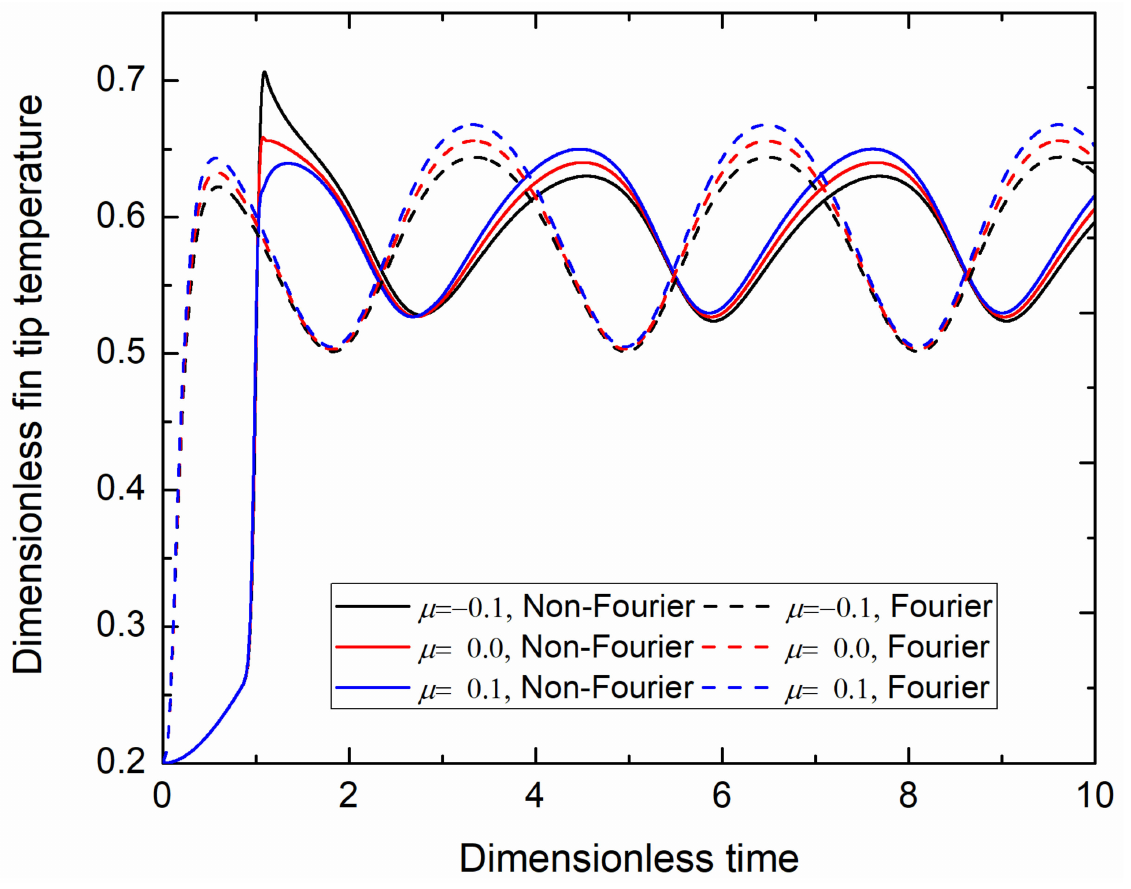
Figure 10. The variation of fin tip temperature at different values of µ